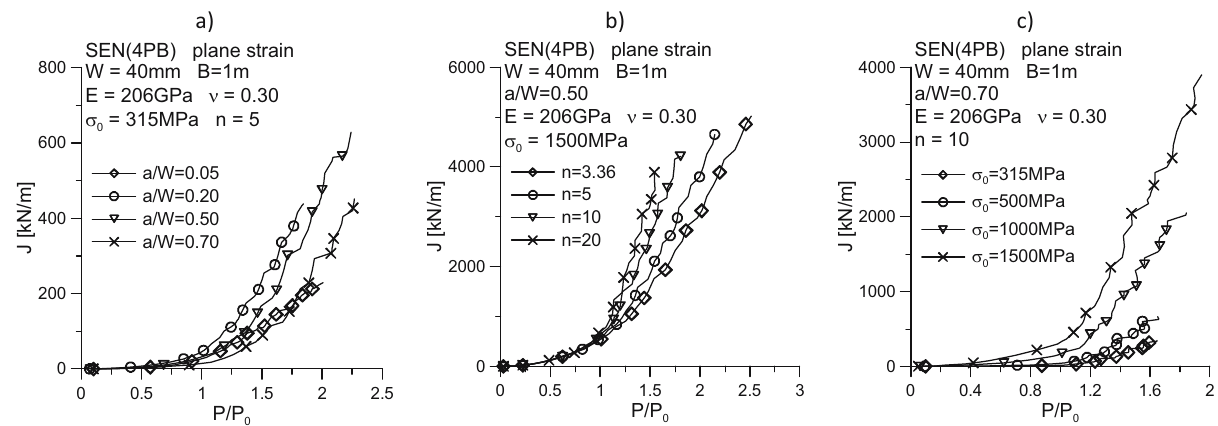
Figure 4: In fl uence of the relative crack length a / W ( a ) , the strain hardening exponent n in the R – O law ( b ) , and the yield point σ 0 ( c ) on the value of the J integral determined numerically as a function of the external load.